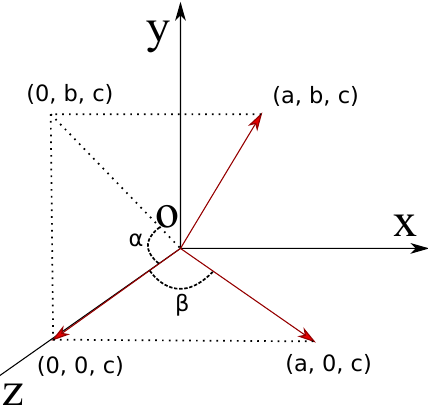
Figure A3. The illustration of the angles between vector axes and coordinate